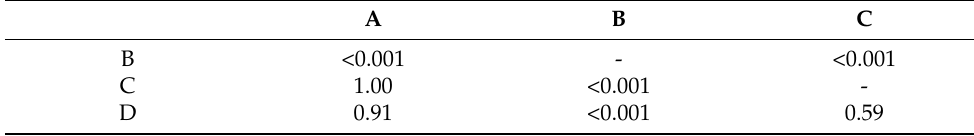
Table 8. Statistical significance of the results ( p -value, post-hoc Tukey analysis). A B